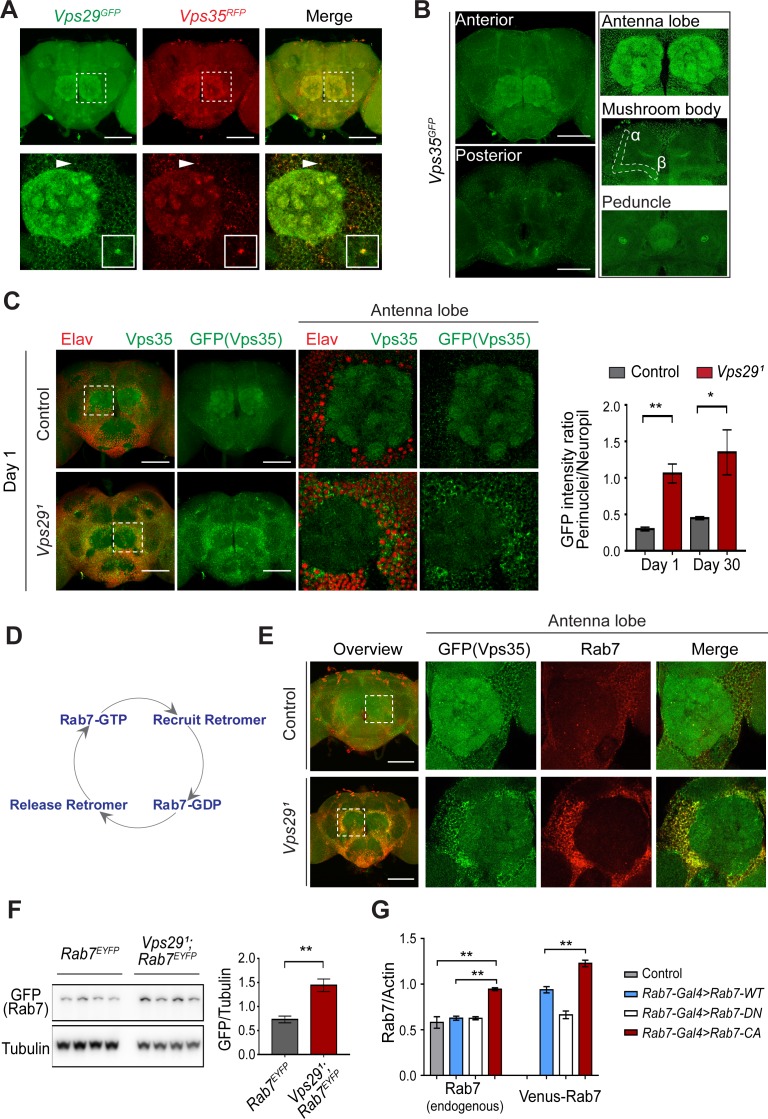
Vps29 regulates Vps35 localization in the adult brain.(A) Vps29GFP (anti-GFP, green) and Vps35RFP (red) are expressed throughout the adult brain and co-localize. Boxed region of interest including antennal lobe (top row) is shown magnified (bottom row). Representative puncta (arrowhead) co-staining for Vps35 and Vps29 is further magnified in inset. Scale bars, 100 µm. (B) Vps35GFP (anti-GFP, green) is modestly enriched in neuropil regions, including the antennal lobes and the mushroom body (α-/β- lobes and peduncles). Scale bars, 100 µm. See also Figure 4—figure supplement 1A. (C) In the absence of Vps29, Vps35GFP (green) protein is redistributed in the adult brain, shifting from neuropil to soma and forming large perinuclear puncta. Neuronal nuclei are labeled with anti-Elav (red). Within the boxed region of interest, including antennal lobe and surrounding nuclei, the GFP intensity ratio (perinuclear to neuropil) was quantified (n = 3) in Vps291, Vps35GFP homozygotes or Vps35GFP controls. Scale bars, 100 µm. See also Figure 4—figure supplement 1B and Figure 4—figure supplement 2. (D) Schematic highlighting the Rab7 cycle including GTP-bound (active) and GDP-bound (inactive) forms and putative interactions regulating retromer recruitment and release. (E) In Vps29 mutants, Vps35GFP (green) colocalizes with Rab7 (anti-Rab7, red), which appears increased and similarly redistributed from neuropil to soma. The region of interest centered on the antenna lobe is indicated in the boxed region of the lower power image (maximal intensity projection); the magnified images are representative anterior single sections taken through the antennal lobe. Scale bars, 100 µm. See also Figure 4—figure supplement 3. (F) Rab7 protein levels are increased in the absence of Vps29. Western blots of adult head homogenates, including Vps291, Rab7EYFP homozygotes or Rab7EYFP controls (2-day-old), were probed for Rab7-YFP (anti-GFP) and Tubulin (loading control). Quantification based on n = 4 replicate experiments. See also Figure 4—figure supplement 4A. (G) Rab7 protein levels are increased in the constitutive active, ‘GTP-locked’ Rab7Q67L mutant. Western blots of adult head homogenates from 5-day-old animals were probed for Rab7 or Actin, including the following genotypes: (1, Rab7-Gal4 > Rab7 CA) UAS-Venus-Rab7 Q67L/+; Rab7-Gal4/+; (2, Rab7-Gal4 > Rab7 WT) UAS-Venus-Rab7 WT/+; Rab7-Gal4/+; (3, Rab7-Gal4 > Rab7 DN) UAS-Venus-Rab7 T22N/+; Rab7-Gal4/+; (4, control) w. Venus-tagged or endogenous Rab7 protein levels were separately quantified, based on n = 4 replicate experiments. See also Figure 4—figure supplement 4B. Statistical analysis was based on Student’s t-test (C, F) or one-way ANOVA (G). To address the possibility of a modestly skewed distribution, the data in C were log2-transformed, and the results of t-tests were unchanged. All error bars denote SEM. *, p<0.05; **, p<0.01.